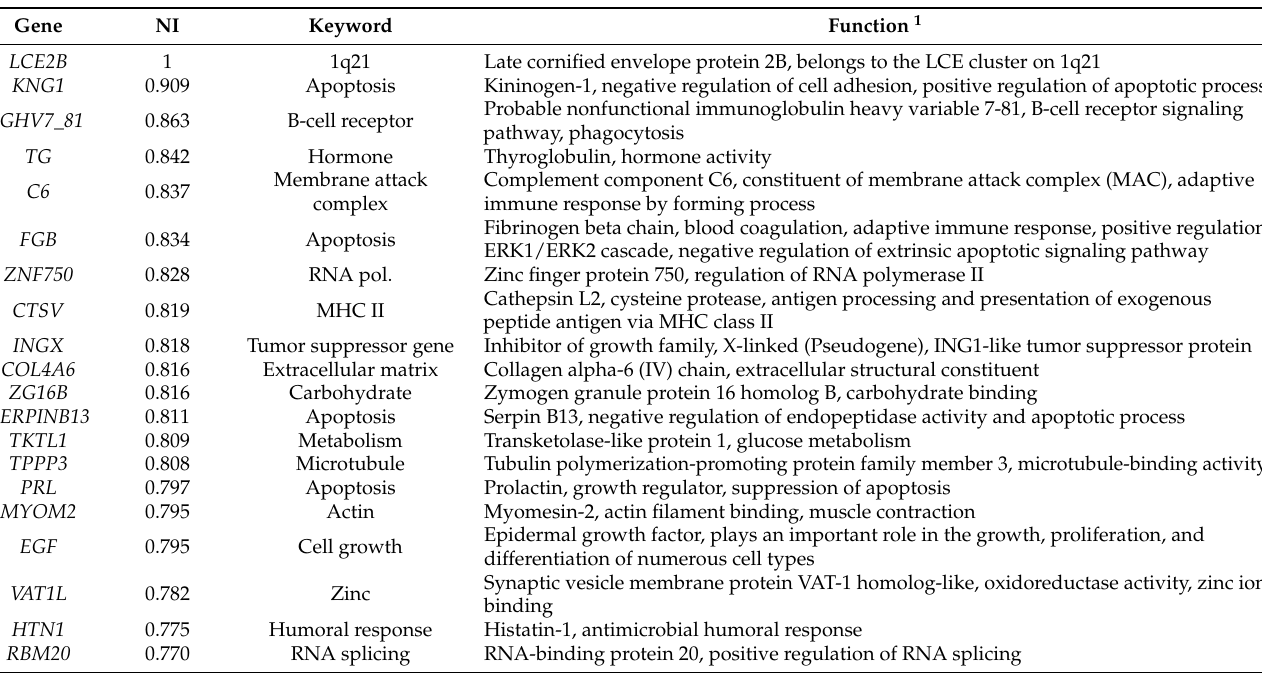
Table 2. Top 20 genes for predicting NHL subtypes (based on all genes set, n = 20,863).